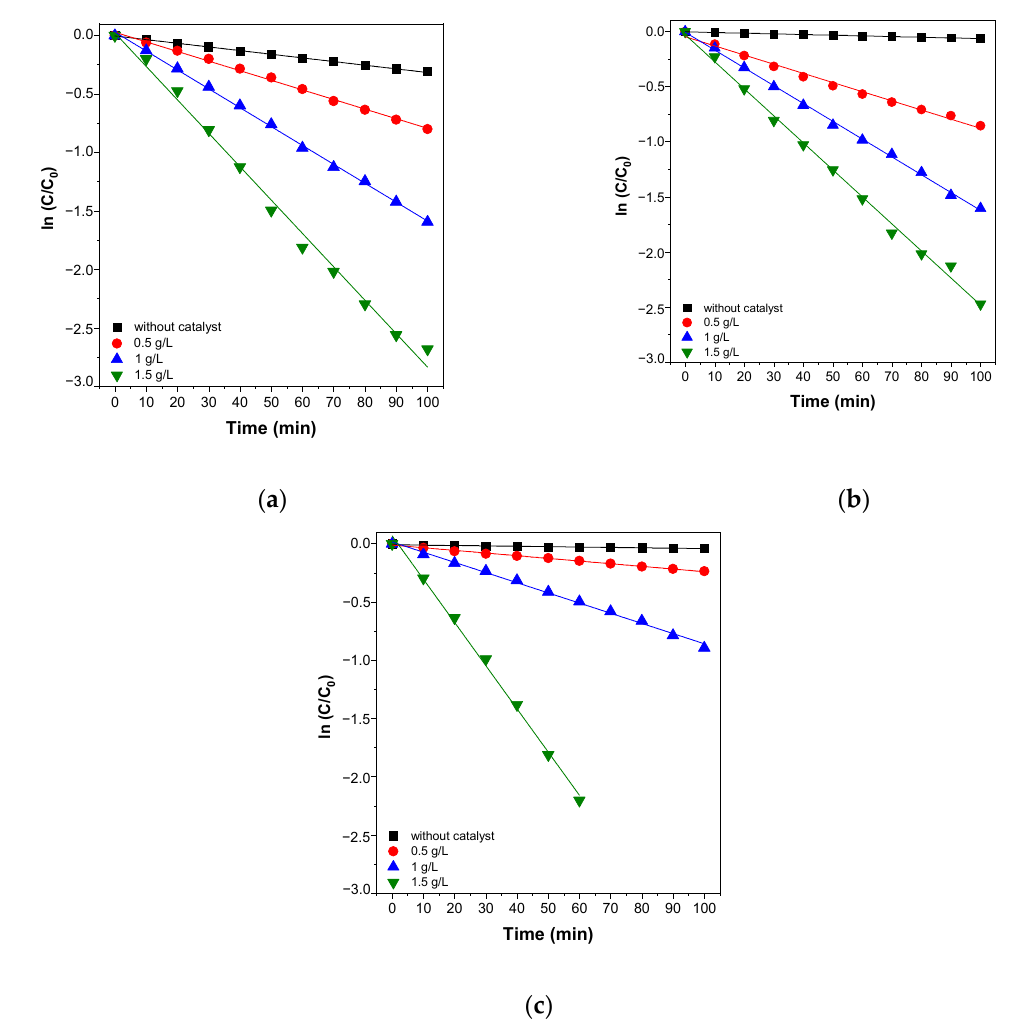
Figure 10. Effect of catalyst dose on the photocatalytic degradation of the azo dyes ( a ) MO, ( b ) AO7, and ( c ) AY23 by Gd 2 O 3 nanoparticles in the presence of H 2 O 2 at pH 5.5. (Experimental conditions: initial dye concentration 0.042 mM; wavelength of UV irradiation: 254 nm; H 2 O 2 concentration: 4.8 M; photocatalyst concentration: 0–1.5 g/L.). Table 1. Reaction rate constant ( k ) and photocatalytic degradation efficiencies (%) of Gd 2 O 3 nano- particles for the degradation of the azo dyes MO, AO7, AY23 in the presence of H 2 O 2 at different catalyst doses.